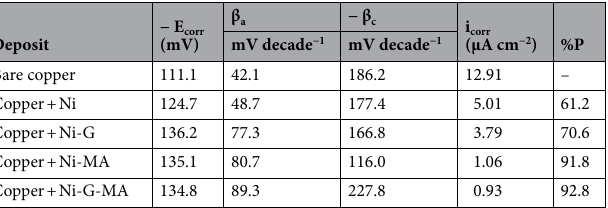
solution, lowering the i corr61 . For SHP copper coated with Ni-G-MA, we observed a further decrease in i corr value (0.93 µA cm −2 ), which could be due to the presence of graphene. The i corr. values for copper coated with Ni and